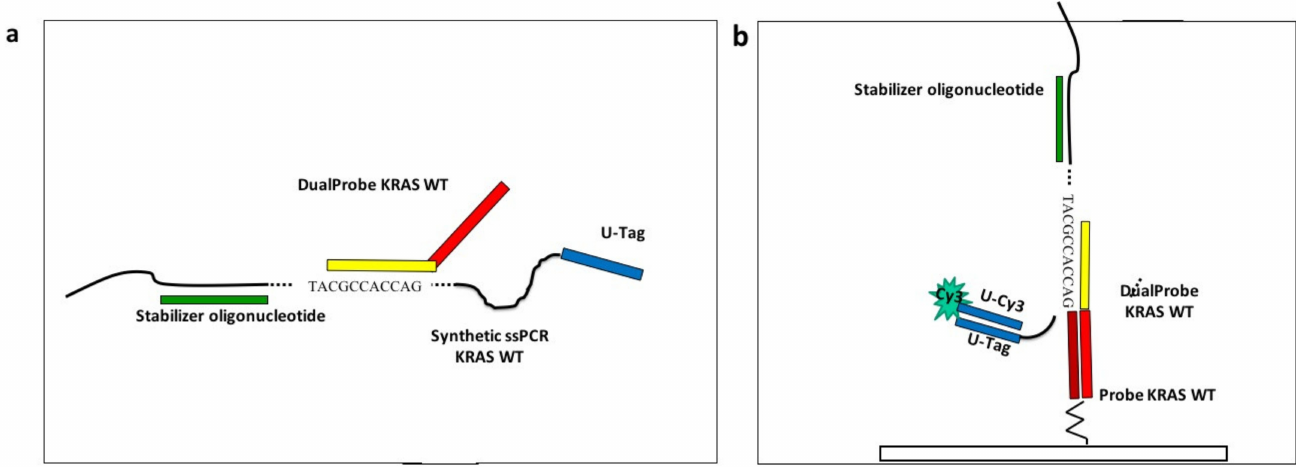
Figure 2. Scheme of the assay. ( a ) In the case of KRAS wild-type allele, the Stabilizer oligonucleotide (green rectangle) hybridizes in solution with the synthetic single strand PCR (ssPCR) to keep the synthetic ssPCR sequence stretched, then the Dual-Probe 5’ domain (yellow rectangle), complementary to the KRAS wild-type synthetic ssPCR, hybridizes in solution with its specific sequence inside the synthetic ssPCR. ( b ) The sequence in the 3’ domain of the Dual-Probe oligonucleotide (red rectangle) directs the synthetic ssPCR to its complementary capture probe on the array (dark red rectangle). The position in the array is revealed when the U-tag sequence at 5’-end of the synthetic ssPCR (blue rectangle) interacts with the complementary Cy3-labeled oligonucleotide, Universal-Cy3 (U-Cy3), added in the last step of the